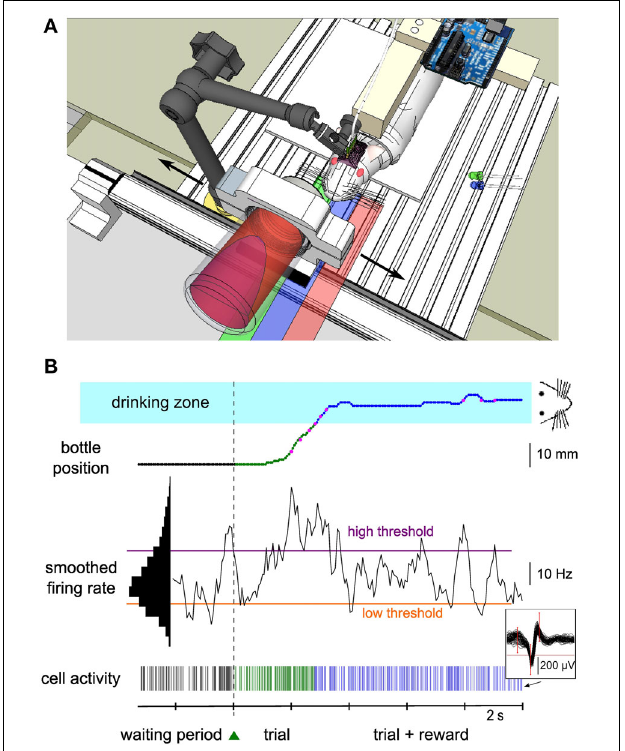
FIGURE 1 | Experimental setup of the neuronal control protocol. (A) Schematics of the experimental setup. The rat was suspended in a harness attached on a PVC bar. Its hindlimbs touched a platform while its forelimbs were free to move. The head was fixed by a mechanical arm that was plugged to a PVC piece embedded into the dental cement of the implant. A bottle containing water and syrup was held by a metal piece placed on a one-dimensional linear axis, perpendicular to the rat’s body. A green LED was placed on the left of the animal. It was switched on and off by a microcontroller mounted on a printed circuit board near the animal to indicate start and end of each trial. The bottle could move in the two directions (black arrows) and the rat could drink when the bottle was close enough to the center (“drinking zone,” blue shaded area). The green and red shaded areas represent the right and left zones explored by the bottle. (B) Bottom, spiking activity of a single neuron (see 60 superimposed action potentials in the inset) during the waiting period (black ticks), during the trial before reward is reached (green ticks) and during the rewarded part of the trial (blue ticks). The smoothed firing rate of the unit (middle) controlled the speed of the bottle toward the rat from a lateral starting position (top). The color of the bottle position curve matches the color of the spiking activity at that time and indicates the waiting/trial status and the bottle position zone in the trial. Magenta dots indicate key positions recorded during the experiment, while the rest of the curve was reconstructed offline (see Methods). The speed of the bottle depended on the difference between the firing rate and two thresholds (purple and orange horizontal lines). Those thresholds were set at fixed percentiles of the firing rate distribution (left black histogram, see Methods). When the bottle was in the drinking zone (blue shaded area), the rat was able to drink while still controlling the bottle position. The green triangle between the waiting period and the trial represents the LED that was switched on to indicate trial onset. Color conventions for the position zones and activity thresholds apply to all figures.